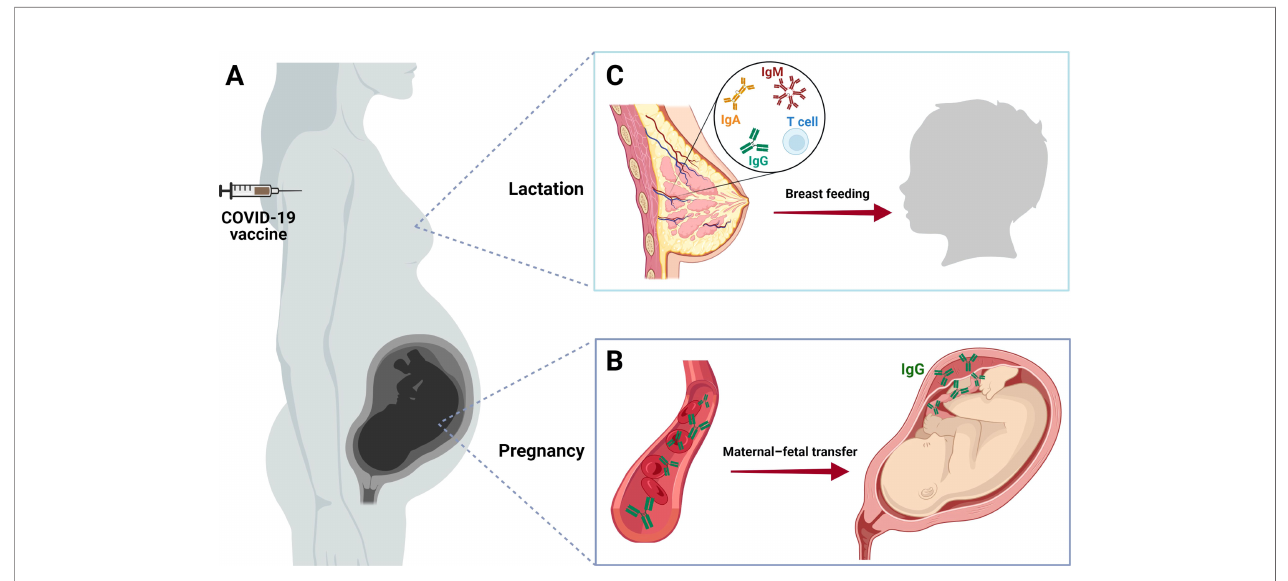
FIGURE 1 | COVID-19 vaccine in pregnancy and lactation. (A) Two pathways of maternal – fetal protection against SARS-CoV-2 after COVID-19 vaccination. (B) After receiving the COVID-19 vaccine, pregnant women start to develop antibodies against the virus (IgG). Thus, immunized women are able to transmit anti- SARS-CoV-2 IgG molecules from their blood to the fetus. This process occurs passively through the placenta, and it is con fi rmed by the presence of these antibodies in cord blood or the newborn serum after birth. (C) Passive immunization of the newborn also happens through breastfeeding, which can be demonstrated by the presence of anti-SARS-CoV-speci fi c IgA, IgM, IgG, and T cells in breast milk. These fi ndings reinforce the importance of pregnant and lactating women to complete the vaccination schedule, protecting themselves and their infants from the severe manifestations of COVID-19. Created with